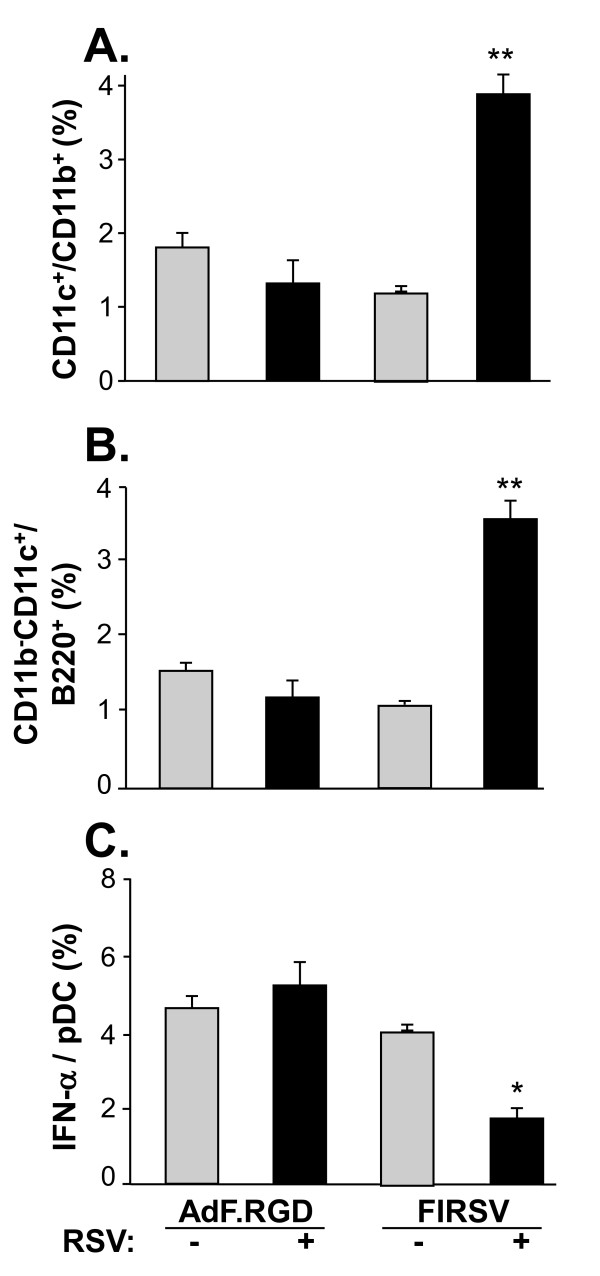
Lung DC and IFN-α secretion following infection with RSV in immunized mice. BALB/c mice were immunized subcutaneously with AdF.RGD (1010 pu/mouse) or FIRSV (105 pfu). A-C. Five wk later the mice were challenged intranasally with RSV (106 pfu) for 6 days and the lung suspensions were analyzed for cDC (CD11b+,CD11chigh), pDC (CD11blow, CD11chigh, B220+, PDCA-1+) and IFN-α secretion by flow cytometry and intracellular cytokine staining. A. cDC. B. pDC. C. IFN-α secretion by pDC. Data are presented as mean ± SEM of 4 mice/group from one of two independent experiments.** and * denote significance of p < 0.01 and p < 0.05, respectively.